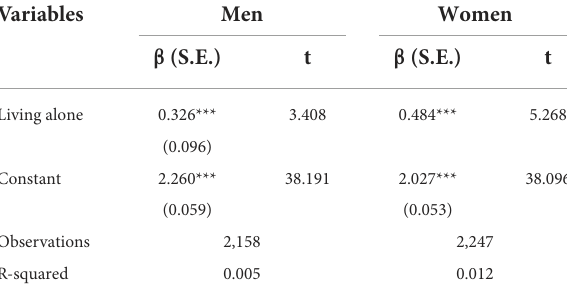
TABLE 3 Effect of the living alone on mental health, by gender.